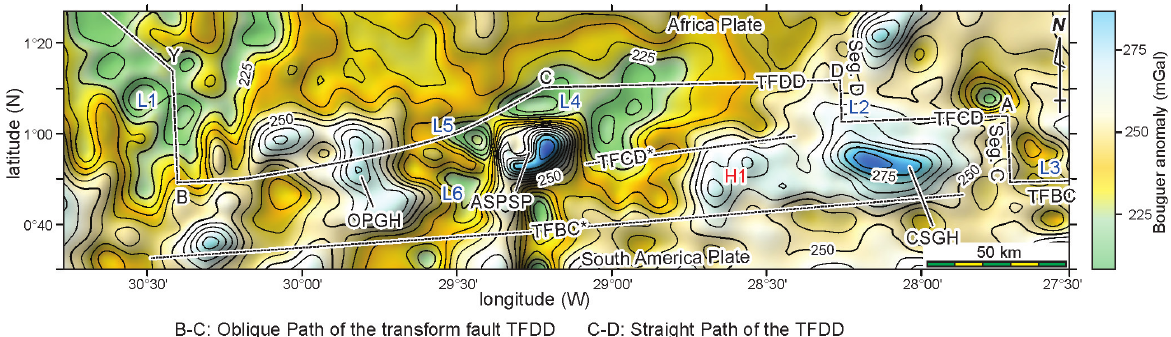
Figure 9 - Bouguer anomaly map based on EGM2008 database in mGal. The name of the transform faults, abyssal fracture zones, and mid-ocean ridge segments are the same of Figure 1. The plate boundary is after Sichel et al. (2011). The L1, L3, L4, L5, and L6 are low Bouguer sites and the H1 is high Bouguer site. The L2 is low in free-air but high in